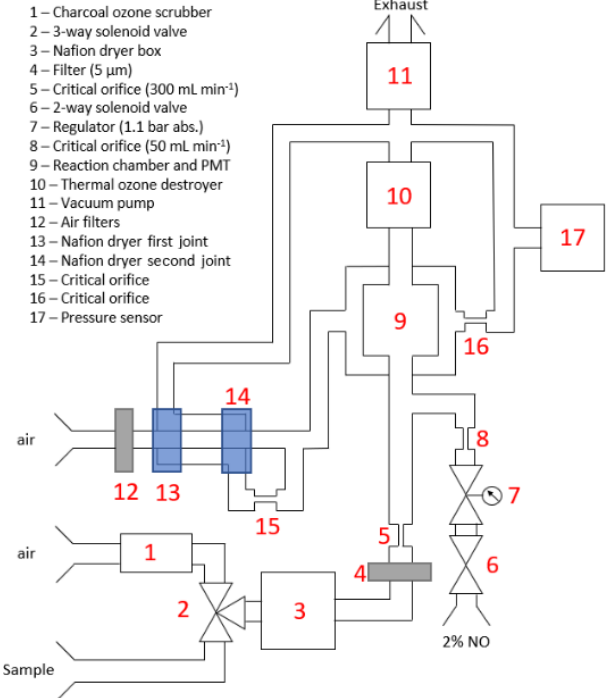
Figure 2. Schematic of the ozone chemiluminescence detector.